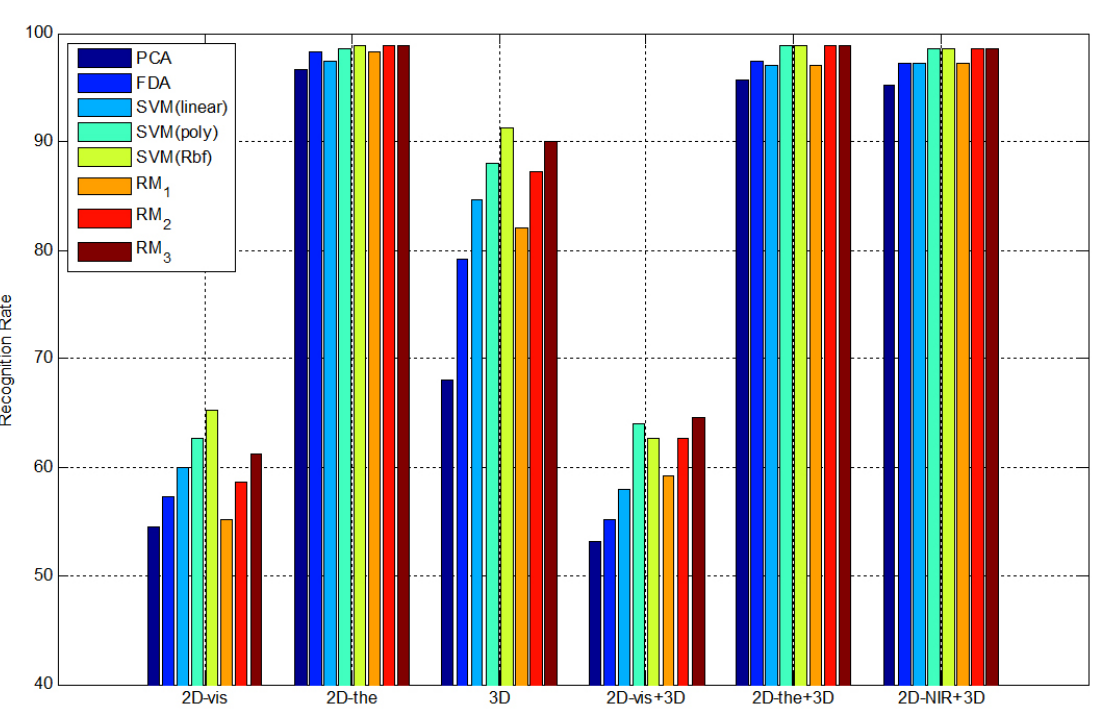
Figure 22. Recognition rate in terms of recognition